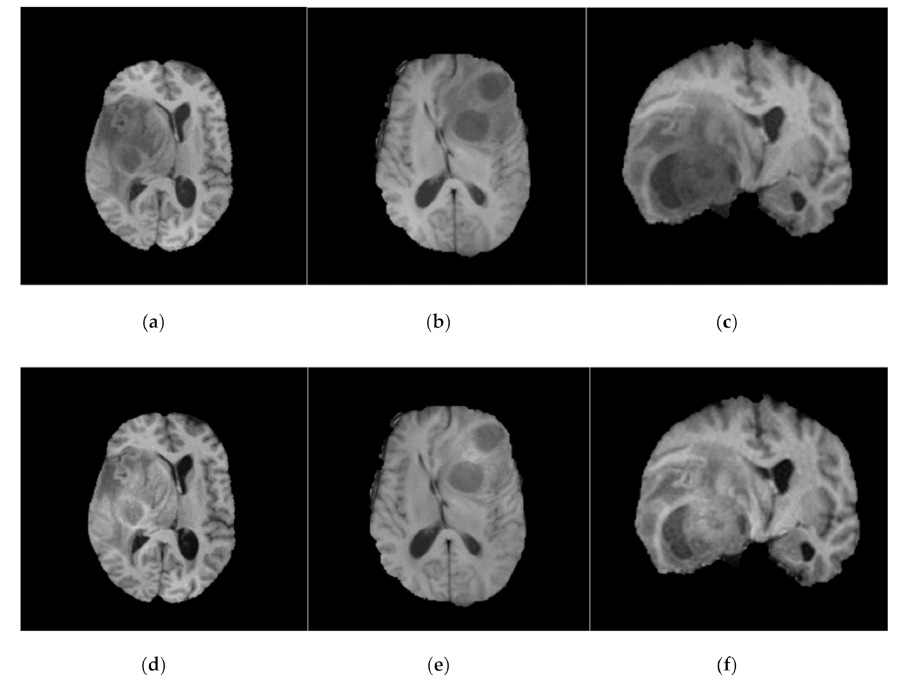
Figure 1. Before ( top row ) and after ( bottom row ) bias field correction. Each MR image in the top row ( a – c ) has the corresponding bias field corrected MR image ( d – f ) in bottom row. All the images shown here are FLAIR (for fair